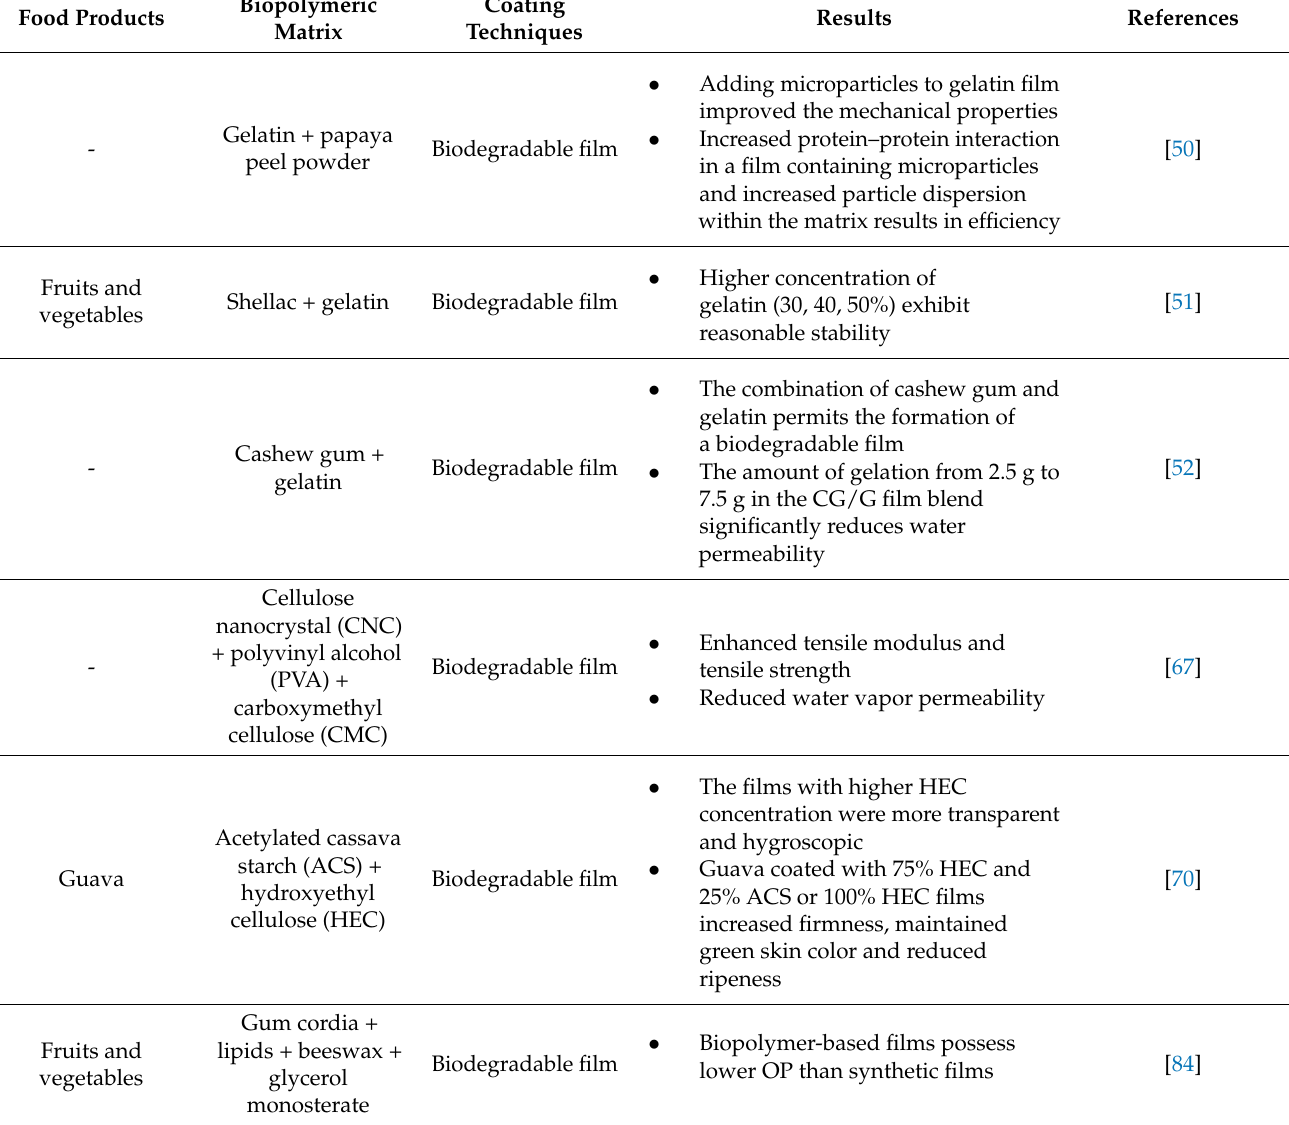
Table 1. Application of biodegradable film in food